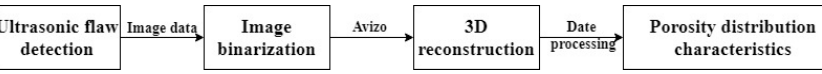
Figure 6. Analysis flow